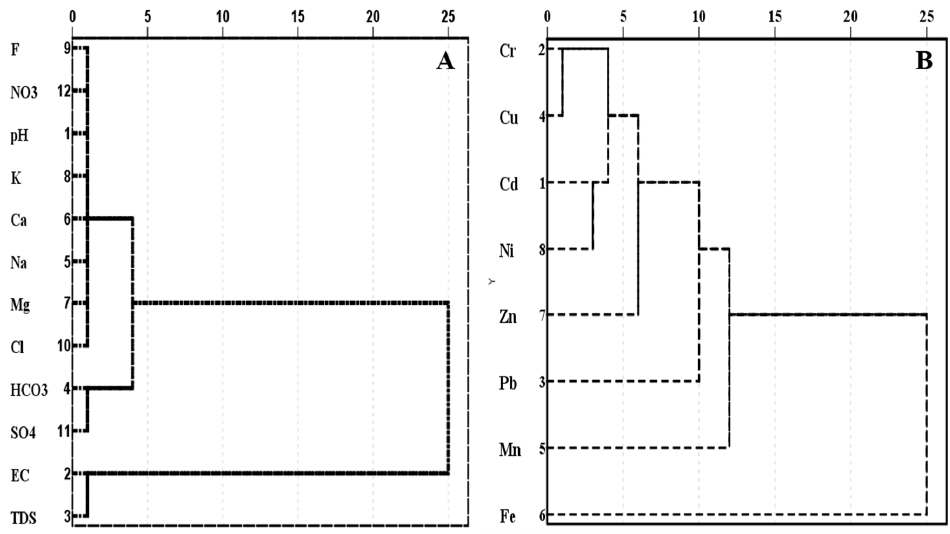
Figure 5. Hierarchical cluster analysis for ( A ) physicochemical parameters of water; ( B ) heavy metal concentration in groundwater.